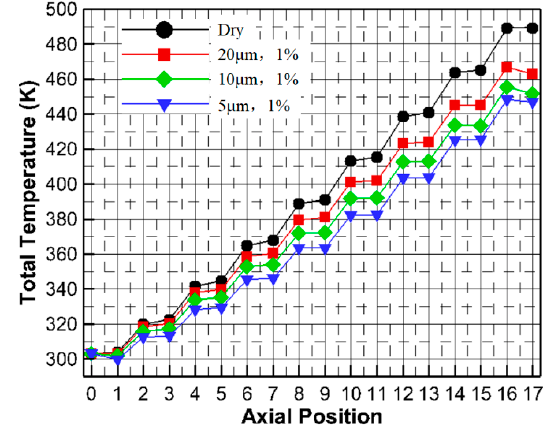
Energies 2018 , 11 , x FOR PEER REVIEW Figure 25. Axial variation of total temperature under injecting water of different droplet sizes.